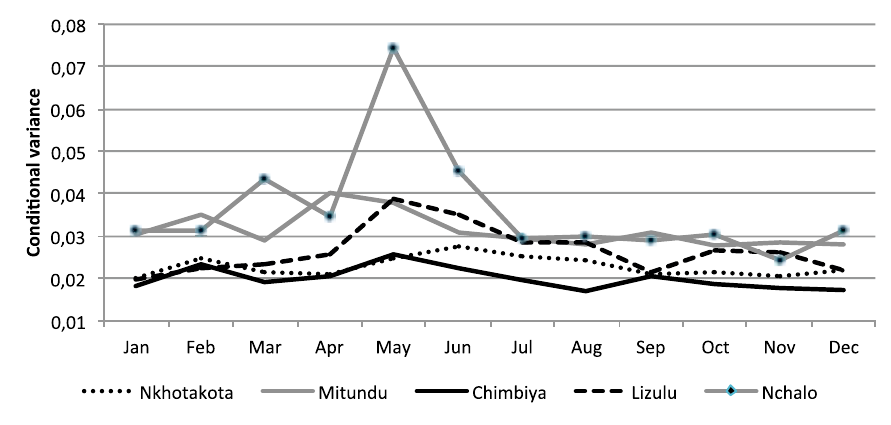
Figure 7. Yearly average conditional variance of the unpredictable component of maize price in the local-economy markets of northern and southern Malawian regions by month (January 1991-March